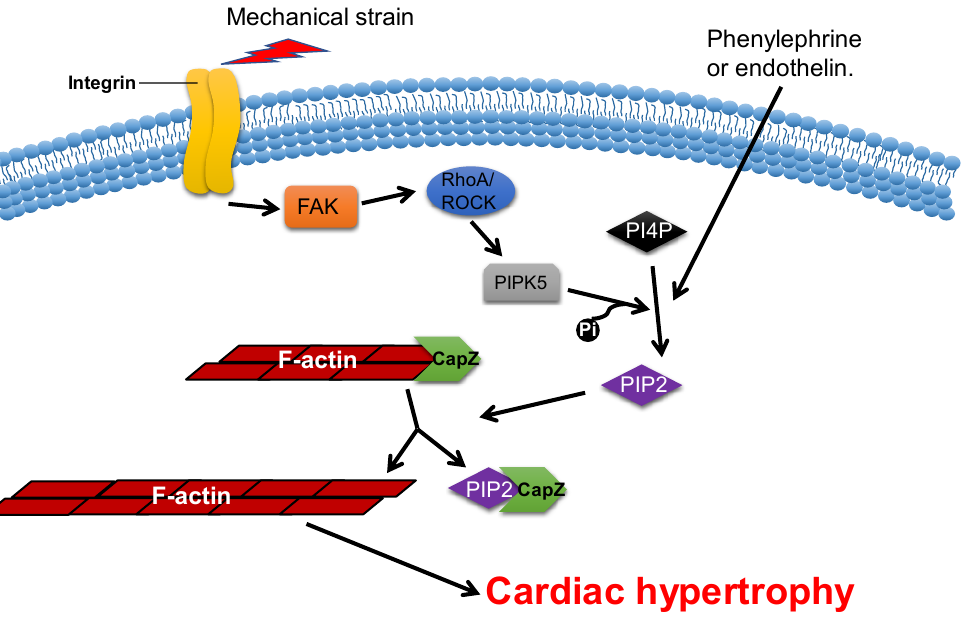
Figure 5. CapZ regulates cardiac hypertrophy. Mechanotransduction leads to the activation of RhoA/Rho-kinase pathway through integrins, which reduce the binding affinity of CapZ and F-actin. It subsequently causes cardiac hypertrophy.